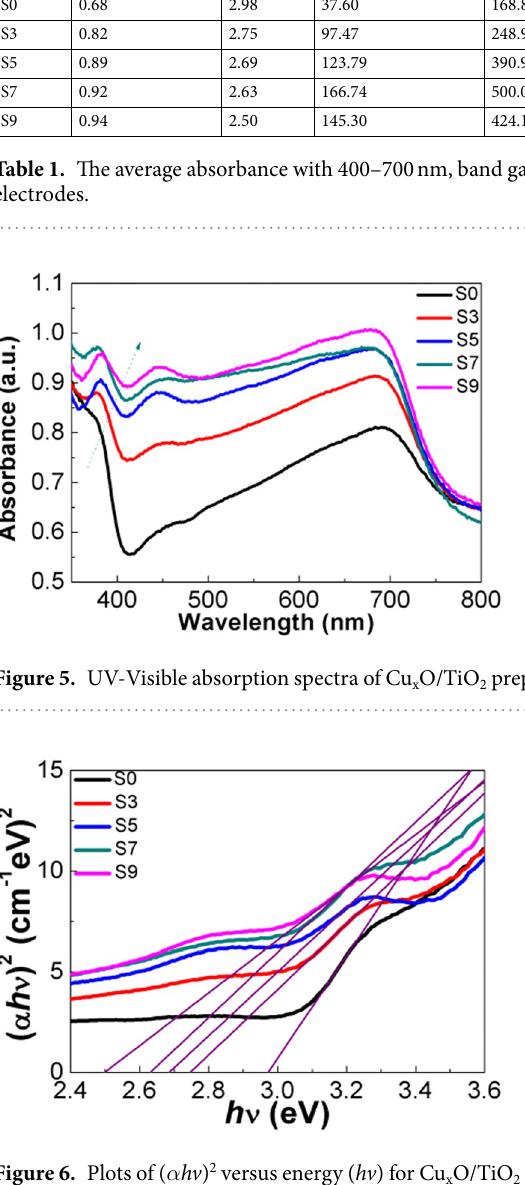
Figure 6. Plots of ( α hv ) 2 versus energy ( hv ) for Cu x O/TiO 2 prepared with different SILAR cycles.